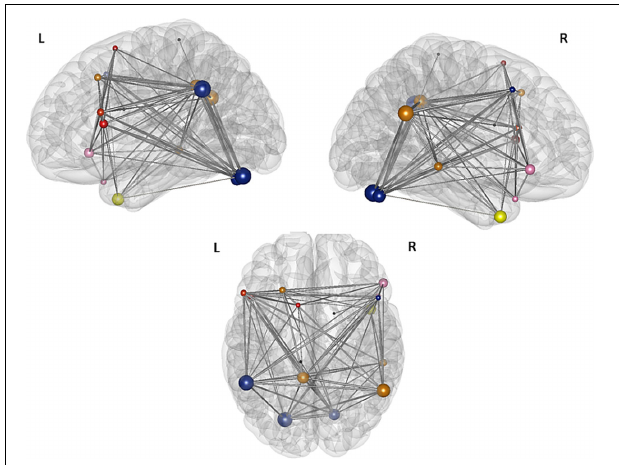
FIGURE 6 | Illustration of the modules after the second modularity analysis. The figure illustrates the result of the partition of the 16 nodes network thesholded at (Fisher transformed) r = 0 . 27. The size of the nodes represents their global efficiency. The edges illustrate the t -values of all of the associations. The nodes of the left frontal module are shaded red, the nodes of the right frontal module are shaded rose—the left and the right frontal modules merge into one single module, the “language module” when the threshold gets more liberal; the nodes of the “connector module” are shaded blue and the nodes comprising the “DMN module” are shaded yellow. The nodes within the caudate nucleus, the right inferior temporal gyrus, and the left paracentral lobule are not assigned to any of the modules and are shaded black.